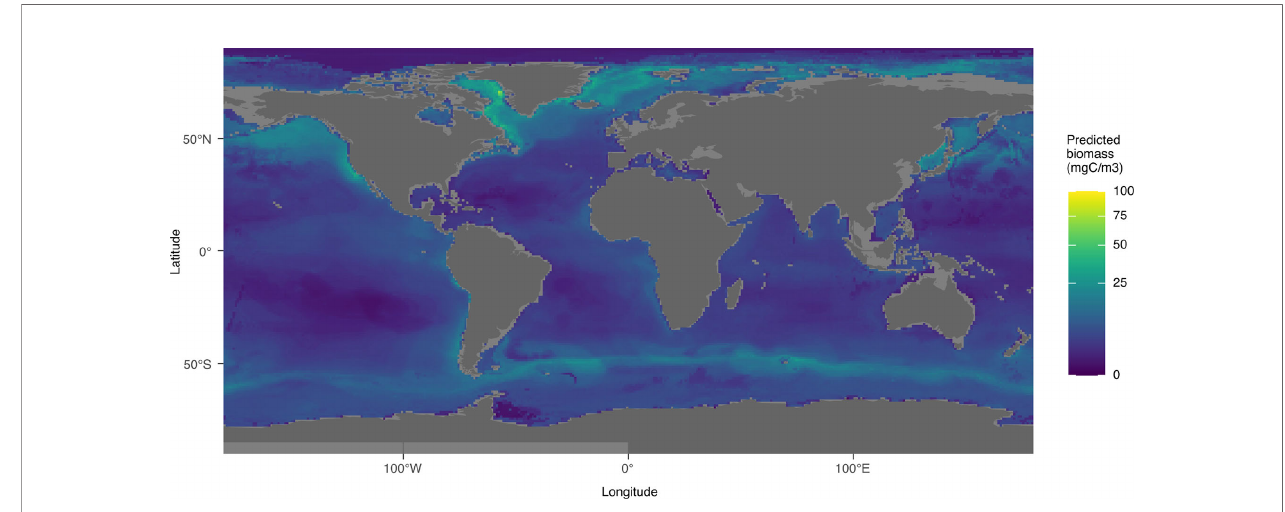
FIGURE 11 | Distribution map of the predicted minimum global biomass between 0 and 500m using taxa which obtained a signi fi cant result (p-value < 0.05) in Pearson test between the predicted biomass and the biomass calculated from UVP5